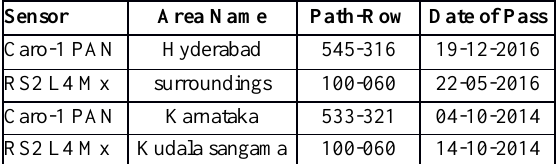
5. RESULTS AND ANALYSIS